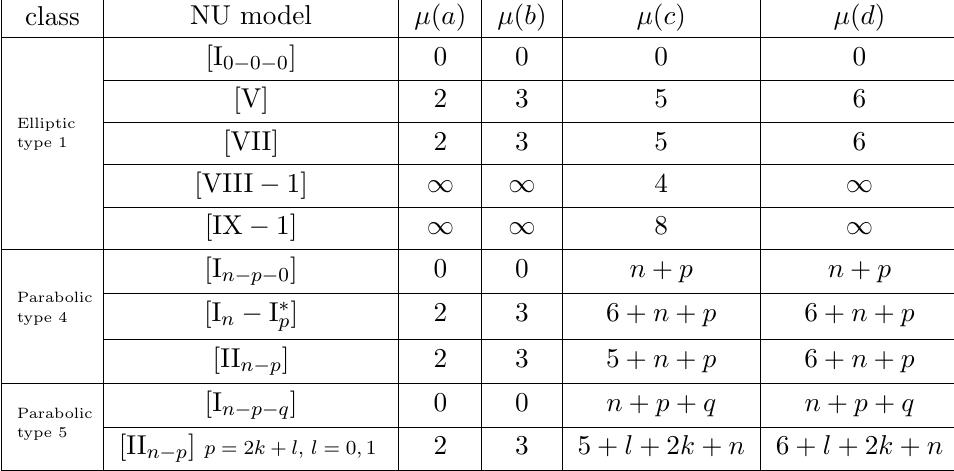
Table 4. Elliptic type 1, parabolic type 4 and parabolic type 5 resolvable